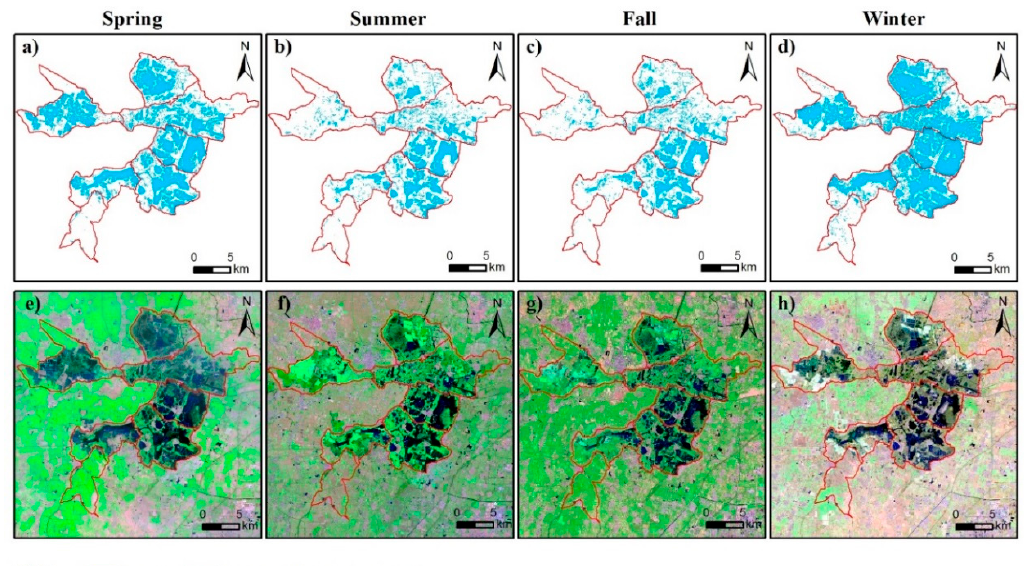
Figure 8. Comparison of water extraction results and original images for all four seasons in 2017. Extracted water surface in the ( a ) spring, ( b ) summer, ( c ) fall, and ( d ) winter of 2017. False color images (bands: 7, 5 and 3) of ( e ) spring, ( f ) summer, ( g ) fall, and ( h ) winter in 2017.